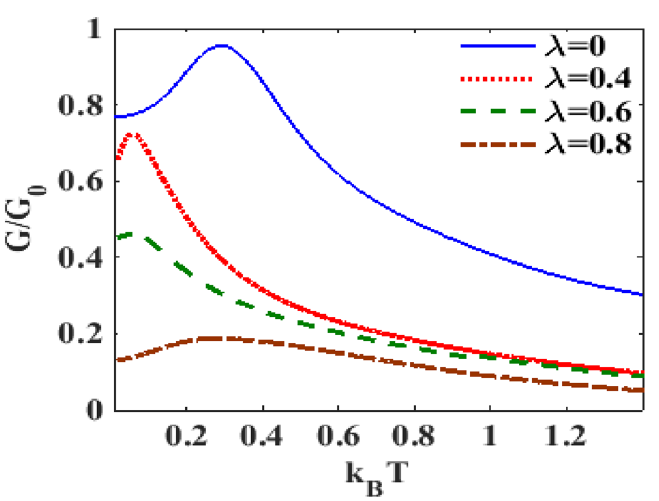
Figure 17. G / G 0 vs k B T for different values of (cid:31) at eV b = 2.5, eV m = 0.5, γ = 0.02